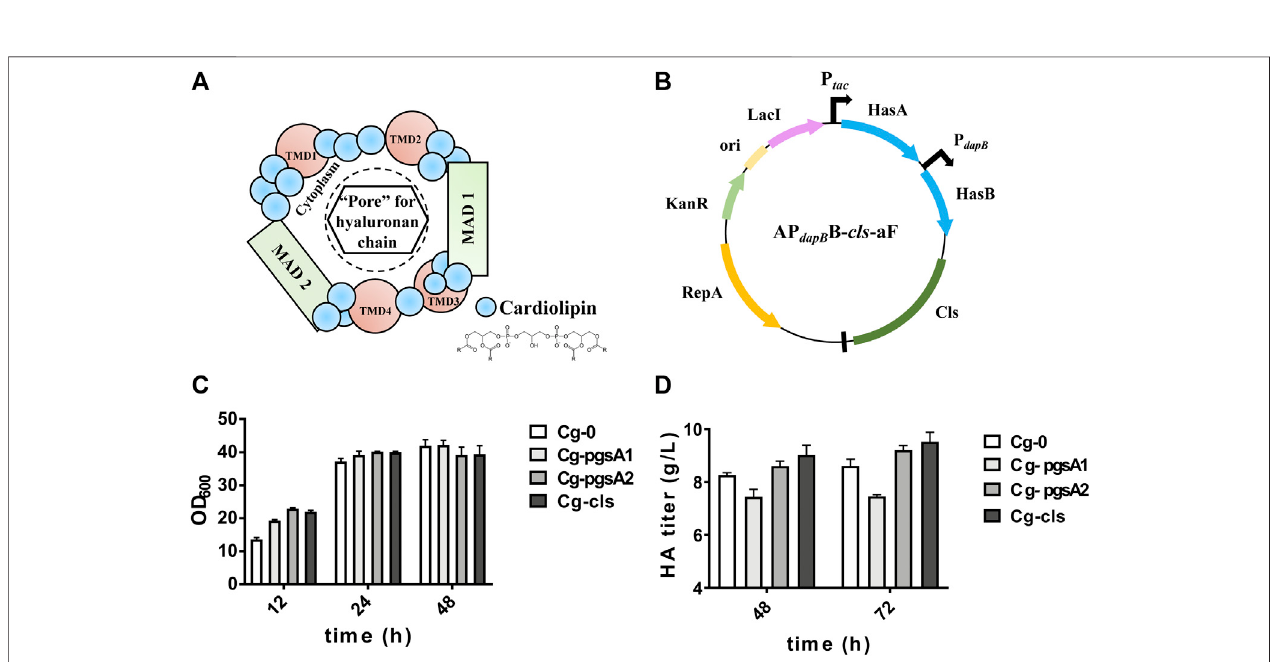
FIGURE 3 | Cell growth and HA titer results after intensi fi cation of CL synthesis. (A) Hypothetical model of the active CLS – HAS complex: the scheme depicts the close association of CL molecules (blue dots) with one HAS protein to create an active enzyme. The growing HA chain would be transferred through this pore-like opening.ThemembranedomainsoftheHASarelabeledastransmembranedomains(TMDs)ormembrane-associateddomains(MADs)(Tlapak-Simmonsetal.,1999). (B) Plasmid map of AP dapB B- cls -aF. (C) OD 600 of the engineered strains Cg-pgsA1, Cg-pgsA2, and Cg-CLS. (D) HA titer of the same engineered strains. Strain Cg-0 was the control. Experiments were performed in triplicate.